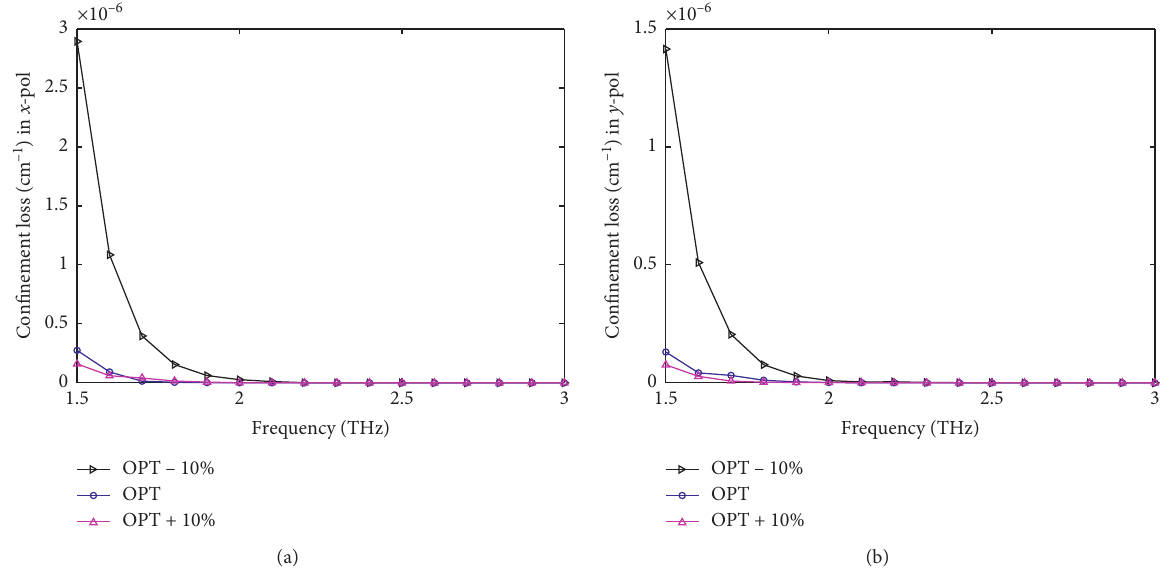
Figure 7: Representation of the CL for the three models in the THz band. (a) x -PoM and (b) y -PoM.